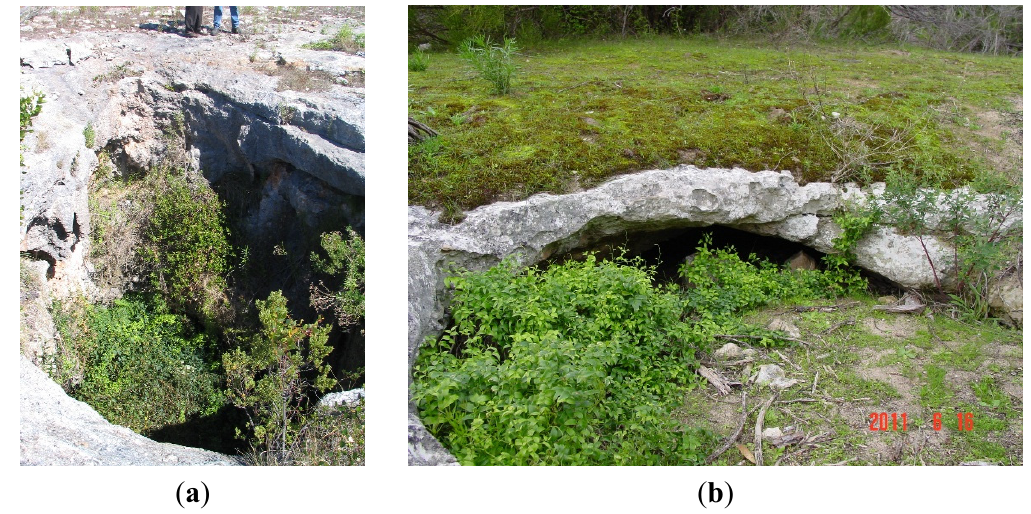
Figure 4. Sinkhole types in Uley South ( a ) Large active solution sinkhole showing upper calcrete layer and below consolidated sediment (calcarenite); ( b ) Large buried sinkhole showing upper calcrete layer and infill